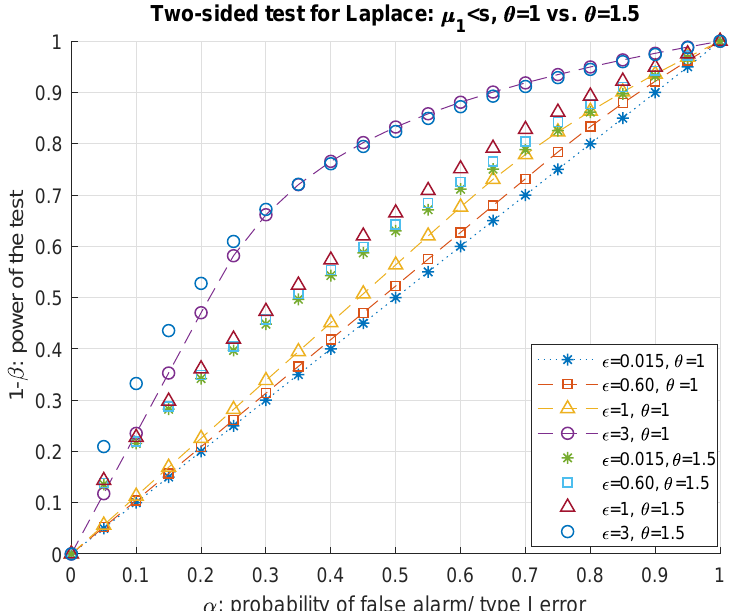
Figure 4. ROC curves for the two-sided hypothesis test ( ∆ µ = µ 1 > 0): (39) vs. (42) depicted for different values of privacy parameter, s > ∆ µ and θ = 1 vs. θ =